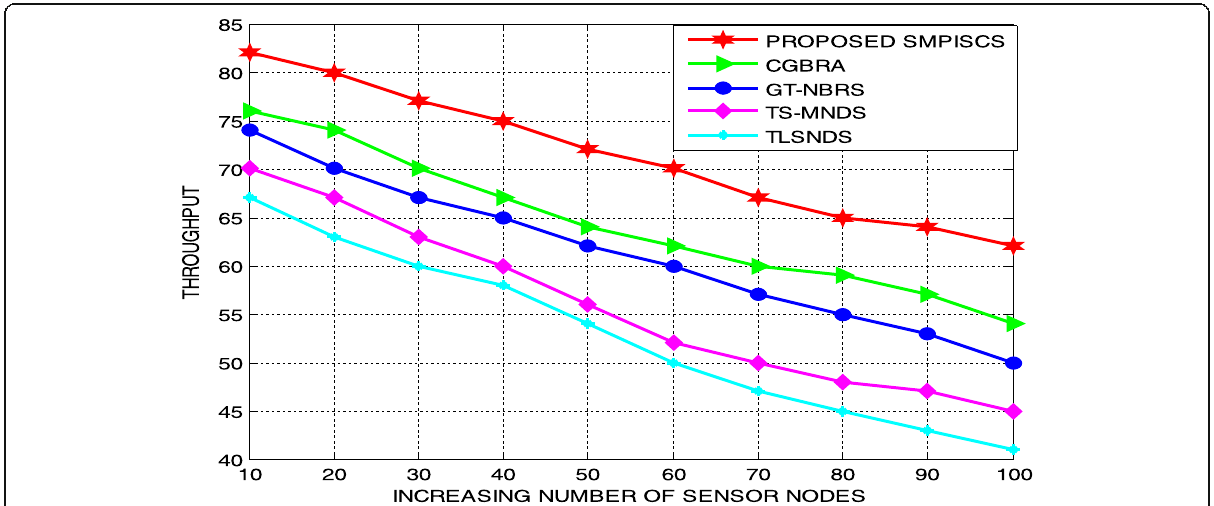
Fig. 4 SMPISCS-Throughput (number of sensor nodes)